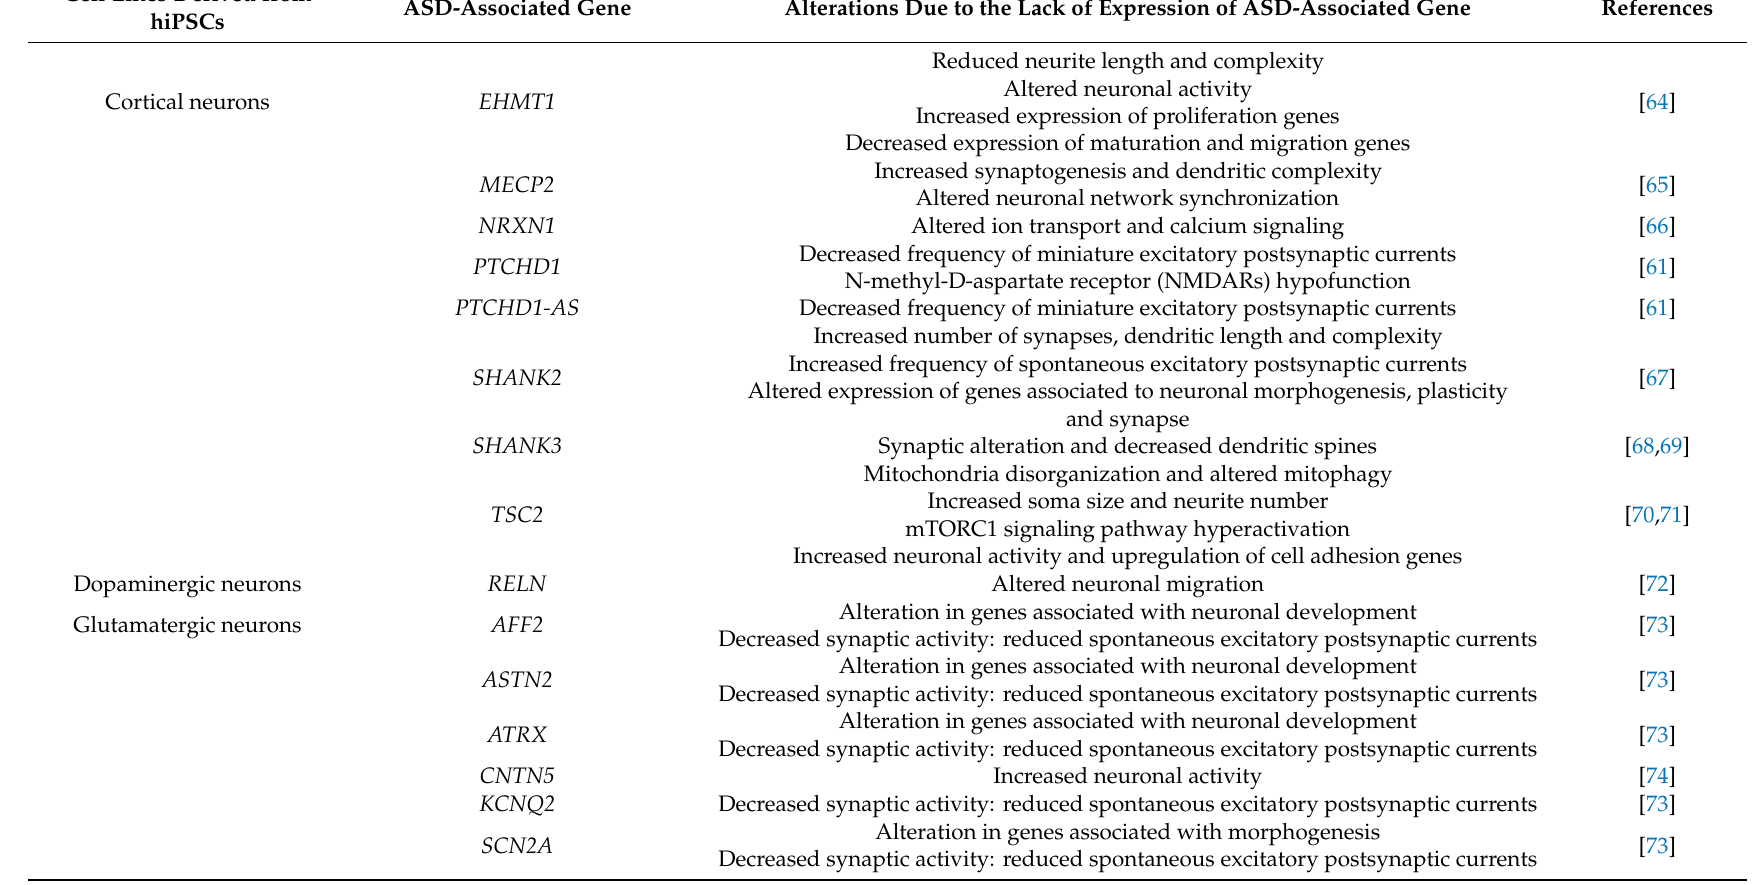
Table 3. Types of alterations observed in neural-like cell lines with a lack of expression of ASD-associated genes. Neural-like cell lines developed to study ASD have been obtained by the di ff erentiation of human induced pluripotent stem cells (hiPSCs) from patients or by the inactivation of the selected ASD-associated gene in controls, using genomic editing